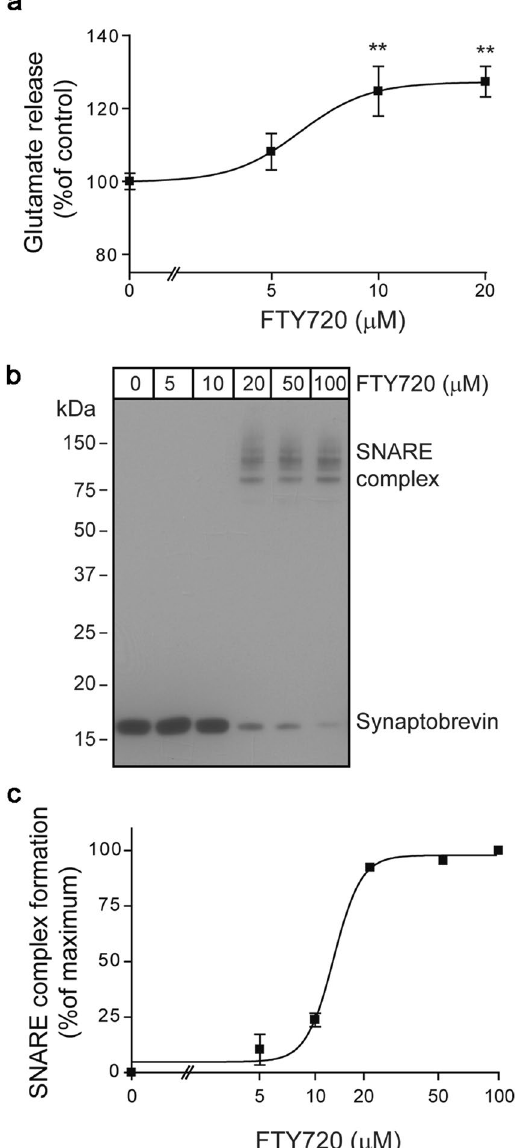
Figure 2. FTY720 accelerates SNARE complex assembly and glutamate release in a dose-dependent manner. ( a ) Graph showing dose-dependence of the FTY720 effect on KCl-triggered glutamate release from rat brain synaptosomes ( ** P < 0.01, ANOVA). ( b ) Immunoblot showing that synaptobrevin on synaptic vesicles engages syntaxin/SNAP-25 only in the presence of FTY720. ( c ) Graph showing the dose-dependence of the FTY720 effect on SNARE assembly in the synaptic vesicle